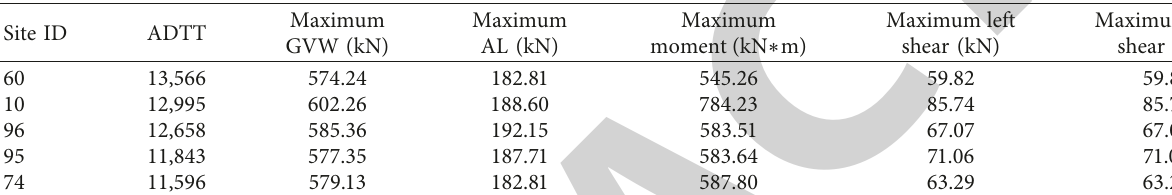
Figure 1: The overview of the process of the recorded data. Table 1: The calculation results for the top 5 sites selected as an example.